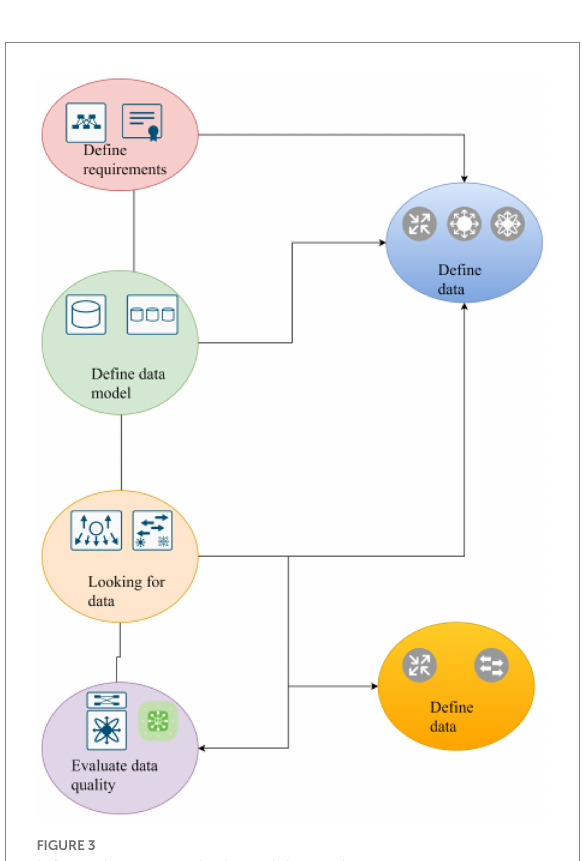
FIGURE 3 Information content in data mining